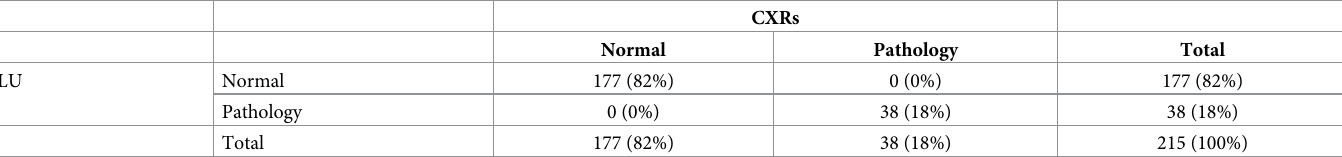
Table 5. Consolidation: The agreement between LU and